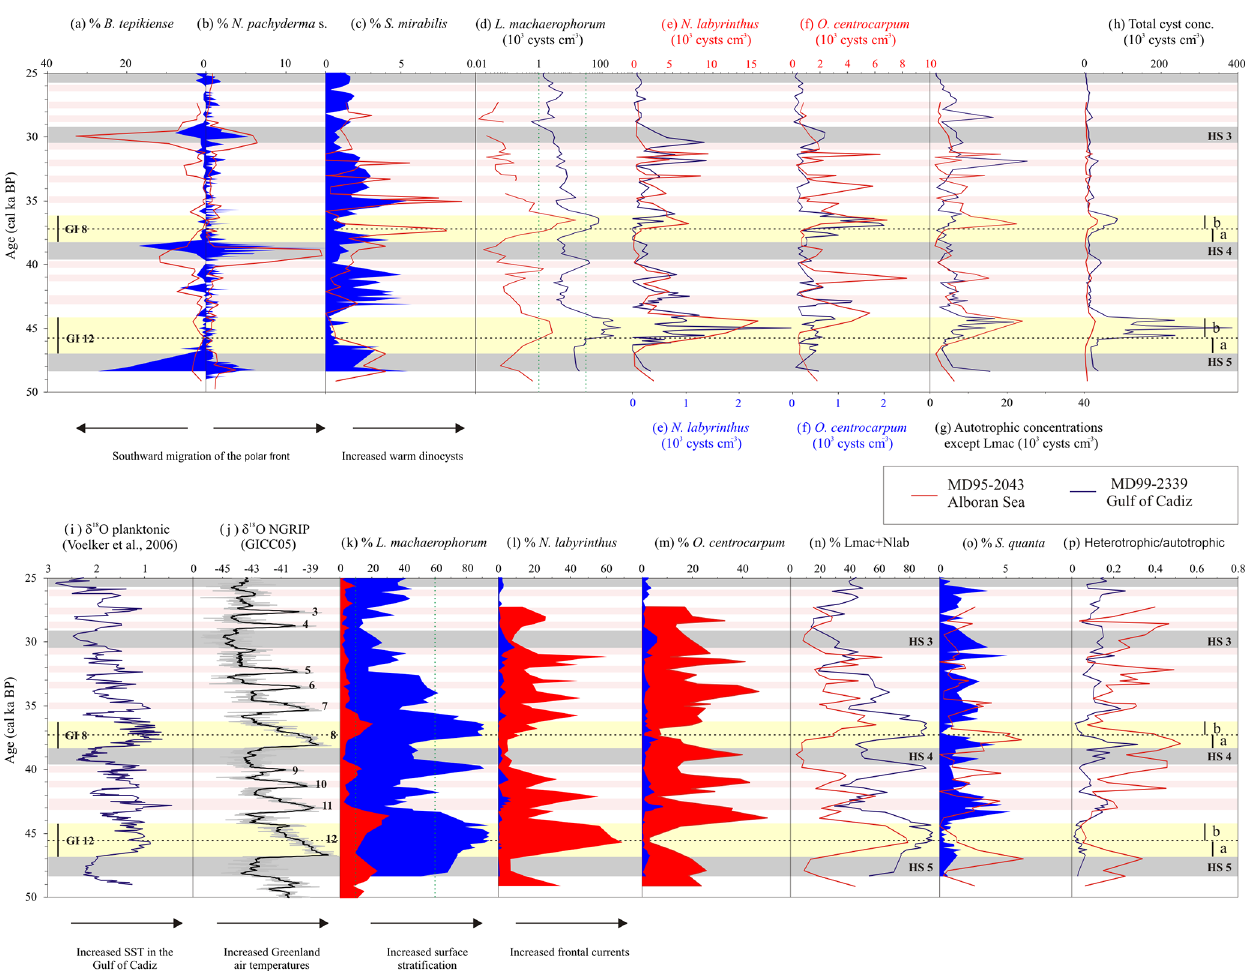
Figure 8. Comparison between dinocyst data (percentages or concentrations) as recorded from each side of the Strait of Gibraltar. Shaded blue and blue curves represent MD99-2339 data (Gulf of Cadiz, this study), while shaded red and red curves represent MD95-2043 data (Alboran Sea, Penaud et al., 2011b). Greenland Interstadials (GI) 8 and 12 are highlighted with yellow bands and are characterized by a bipartite structure labelled “a” and “b” for the first and second phases, respectively. Other GIs are highlighted with pink bands also corresponding to the numbered peaks obvious on the NGRIP curve. Grey bands indicate Heinrich Stadials